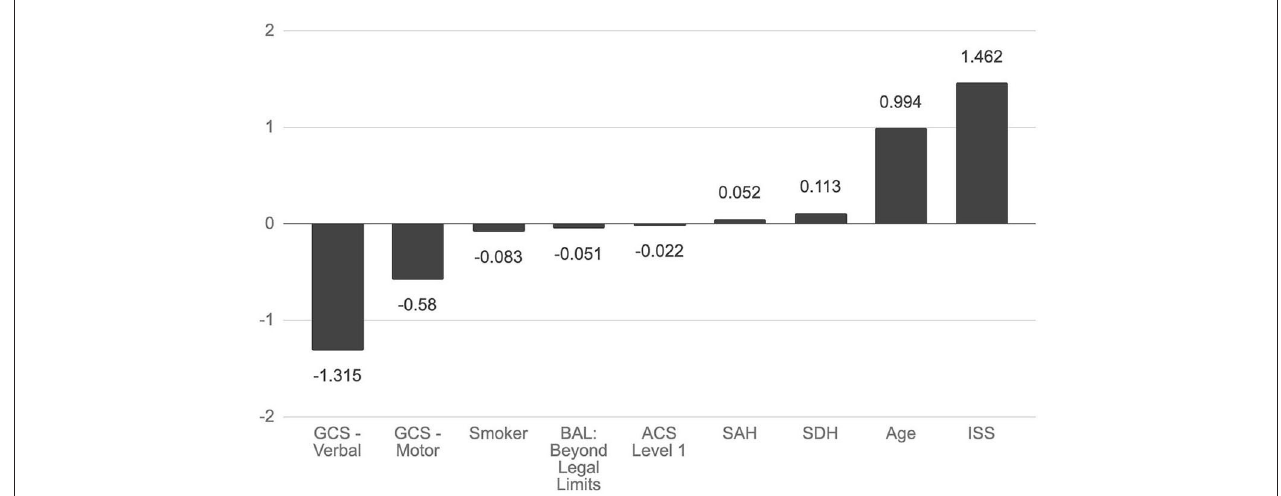
FIGURE 2 | Association of selected features with mortality. Nine features were selected in constructing a hyperplane to separate mortality outcomes. The magnitude of the feature’s coefficient is proportional to its importance in predicting mortality outcomes. GCS, Glasgow Coma Score; BAL, blood alcohol level; ACS, American College of Surgeons; SAH, subarachnoid hemorrhage; SDH, subdural hemorrhage; ISS, Injury Severity score.